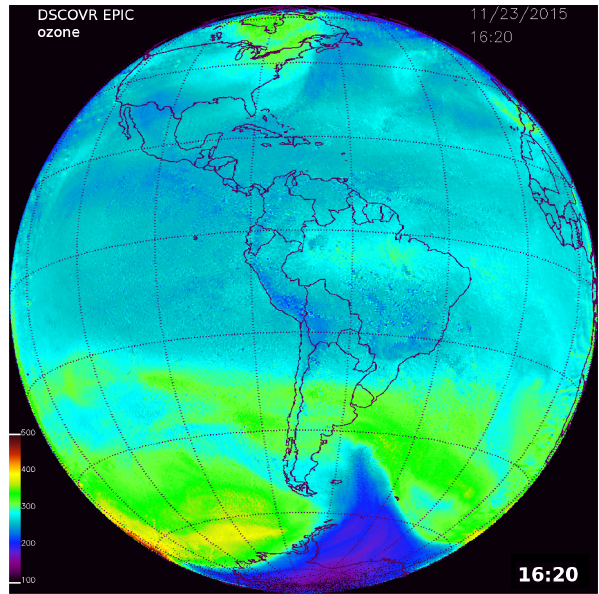
Figure 10. Global image of ozone field for Fig. 11 for 23 November 2015 at 16:20